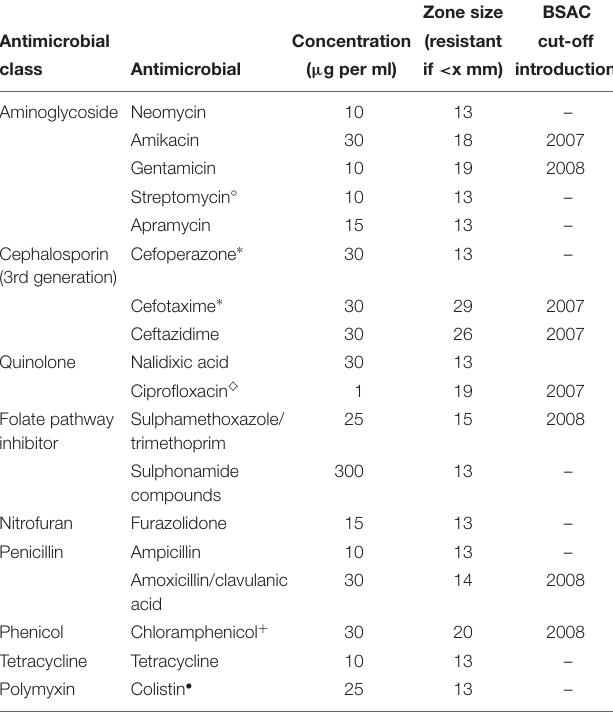
TABLE 1 | Antimicrobials used for resistance phenotyping of Salmonella Typhimurium isolates at the Animal and Plant Health Agency between 2003 and